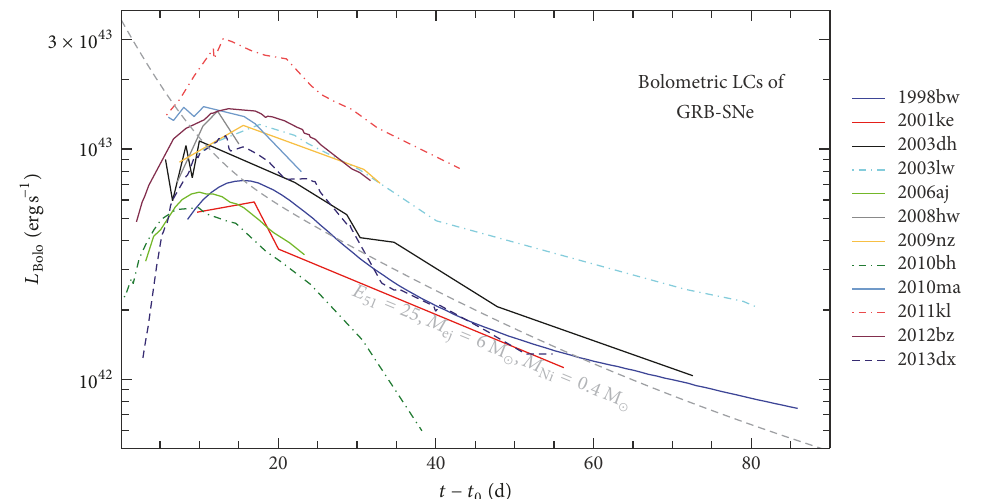
Figure 9: Bolometric LCs of a sample of GRB-SNe. Times are given in the rest-frame. The average peak luminosity of all GRB-SNe except = 1.0×10 43 erg s −1 , with a standard deviation of 0.36×10 43 ergs −1 . The peak luminosity of SN 2011kl is 𝐿 SN 2011kl is 𝐿 p which makes it more than 5 𝜎 more luminous than the average GRB-SN. The average peak time of the entire sample is 𝑡 standard deviation of 2.6 d. If SN 2011kl is excluded from the sample, this changes to 13.0 d. Plotted for reference is an analytical model that considers the luminosity produced by the average GRB-SN ( 𝐸